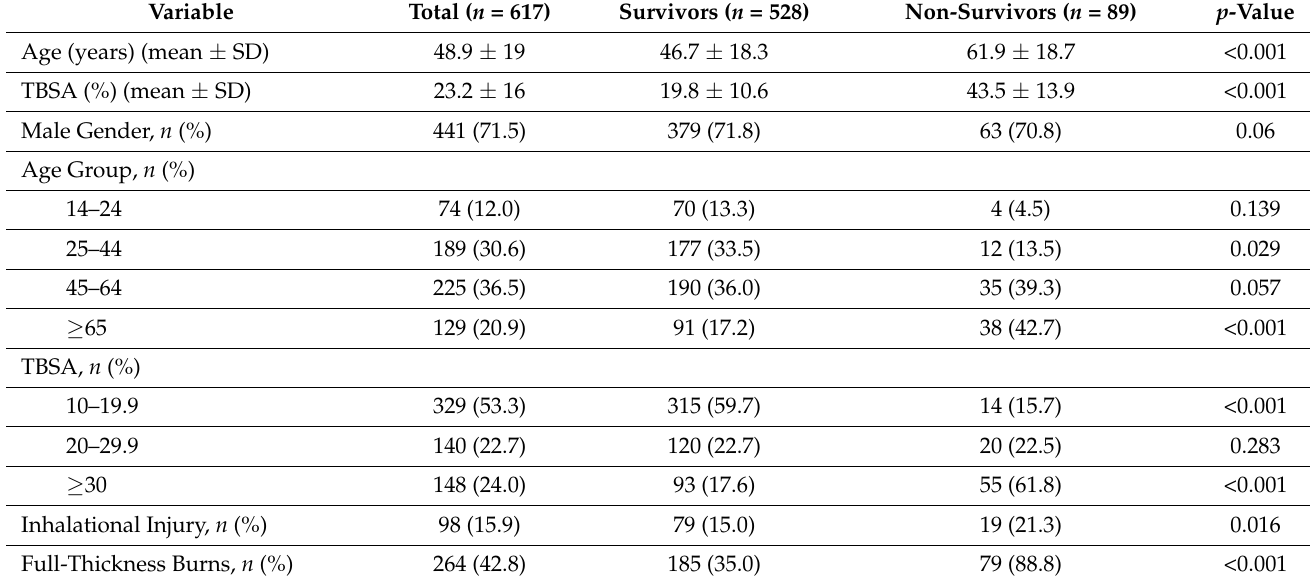
Table 2. Clinical characteristics and